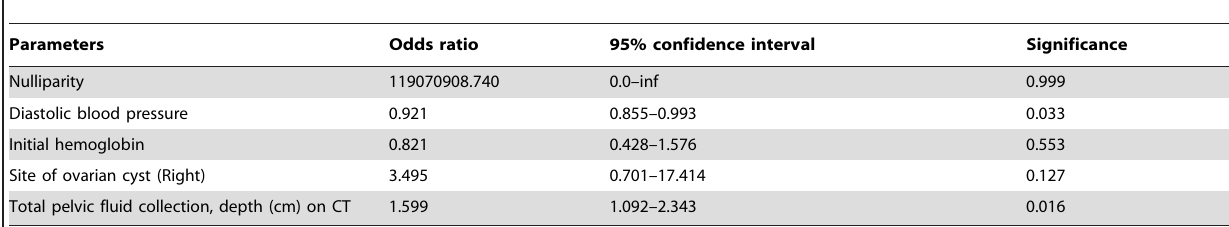
Table 2. Logistic regression results for predicting surgical intervention in patients managed for ruptured ovarian cysts with